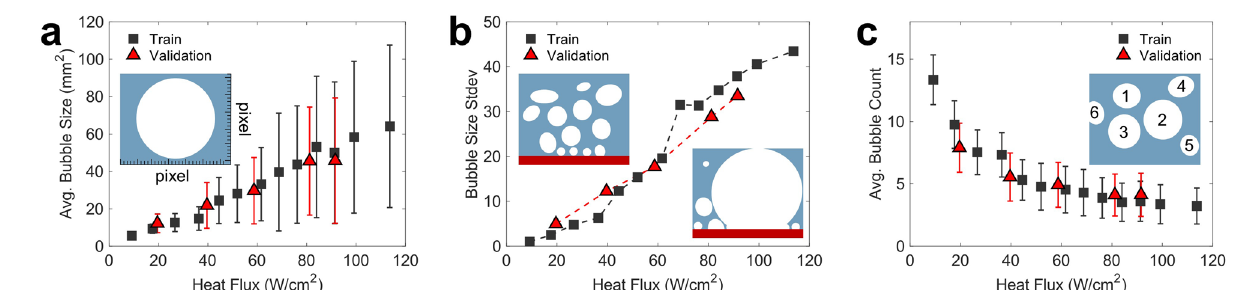
Figure 3. Bubble statistics with varying heat flux. ( a ) The average bubble size and boiling heat flux display a linear relationship. The error bars represent the standard deviation. The inset shows that the bubbles sizes are originally extracted as pixel values. The pixel values are converted to mm 2 bubble sizes using a commercial program ImageJ and then averaged over the corresponding heat flux. ( b ) The bubble size standard deviation, in turn, characterizes bubble size differences of a given step and also exhibits a near-linear trend. Low heat fluxes have small standard deviations, which means bubbles sizes are relatively uniform. As heat flux increases, the difference becomes small and large bubbles become increasingly noticeable and is reflected in the plot. The bubble size differences for low and high heat fluxes are illustrated in the inset. ( c ) The average bubble count decreases exponentially due to vigorous bubble coalescence as boiling heat flux increases. The inset portrays individual bubbles that are identified and